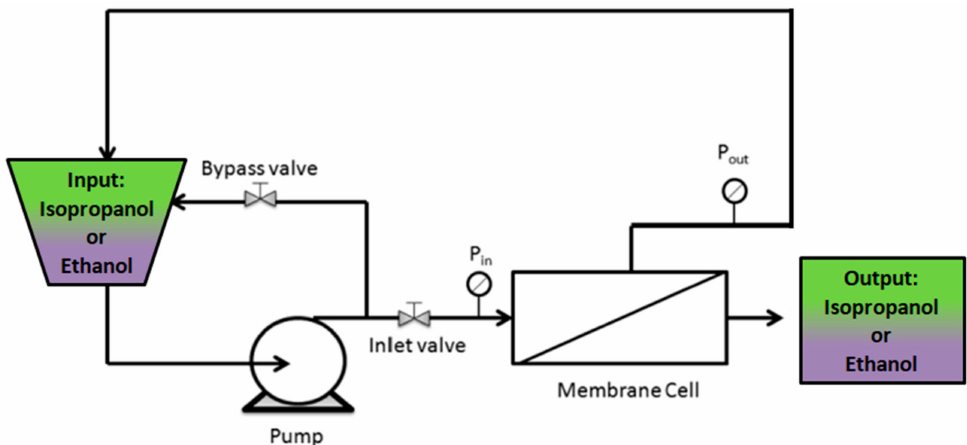
Scheme 1. Flow diagram of the cross-flow nanofiltration apparatus.